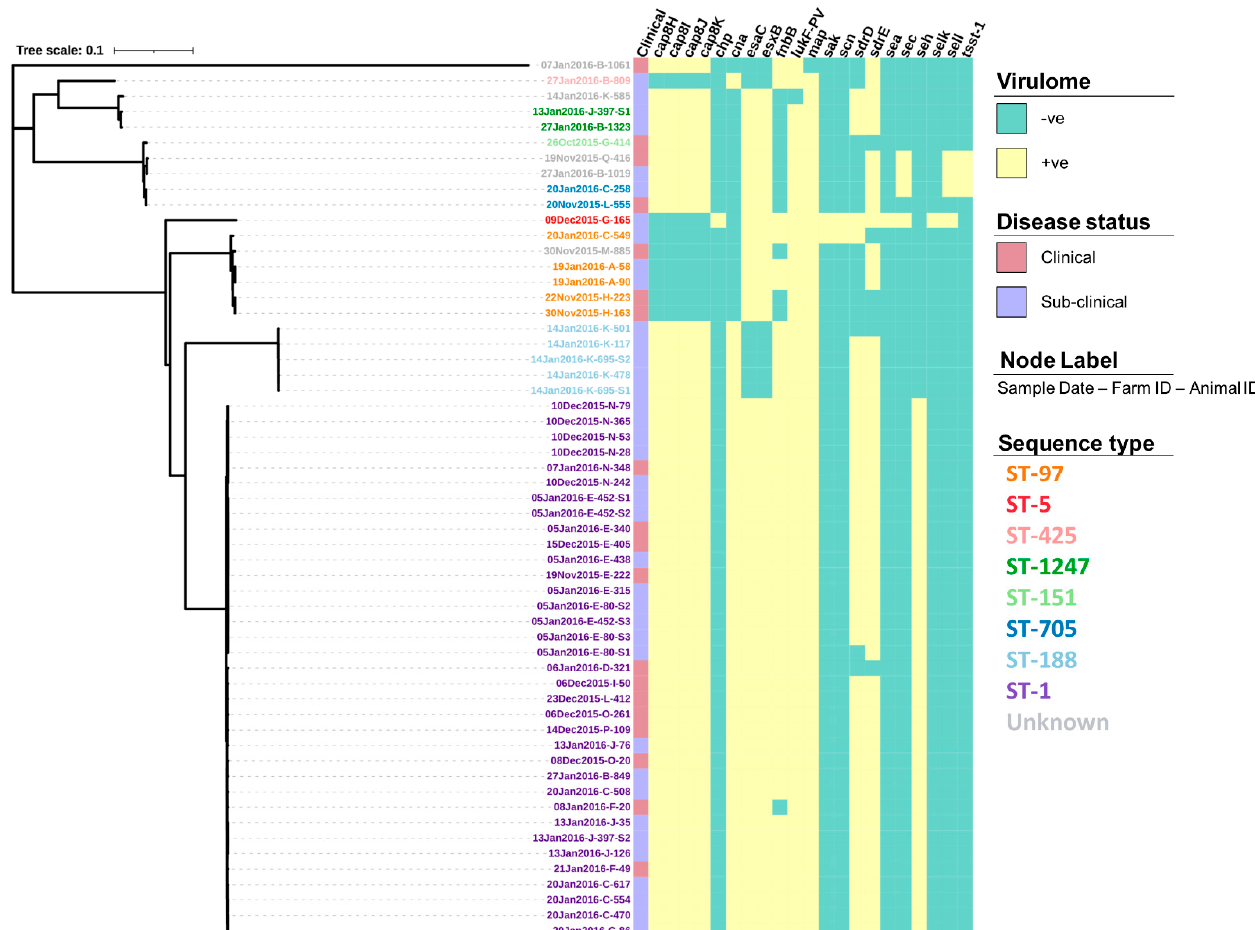
Figure 4. Virulence gene profiles of 57 S. aureus isolates presented alongside a maximum-likelihood tree generated from the core single nucleotide polymorphisms. Isolate IDs identify the date the sample was collected (dd/mm/yyyy), the farm from which it was collected from (A–Q), and the animal ID number.